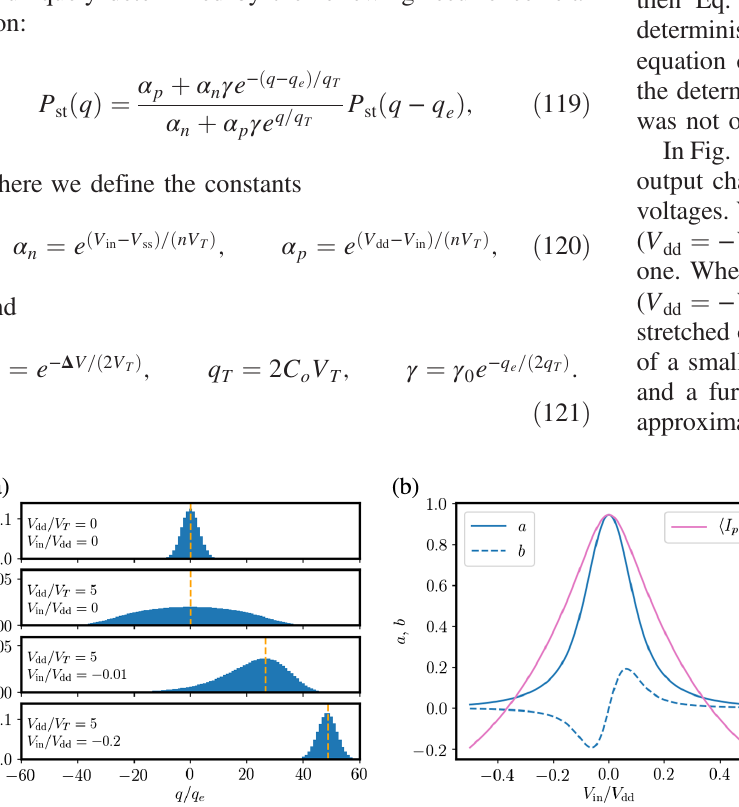
0 . 1 ). Here =q e T ¼ ; in =t 0 , with e